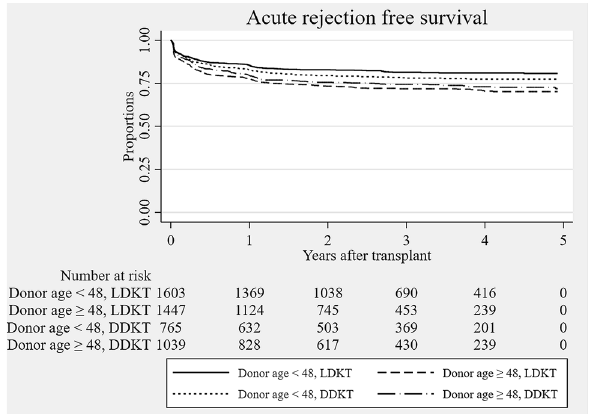
Figure 4. Acute rejection-free survival of kidney transplant recipients according to donor age and the types of organ donor. Donor age of 48 years old was selected as the optimal cutoff points among this study population. DDKT, deceased donor kidney transplantation; LDKT, living donor kidney transplantation.